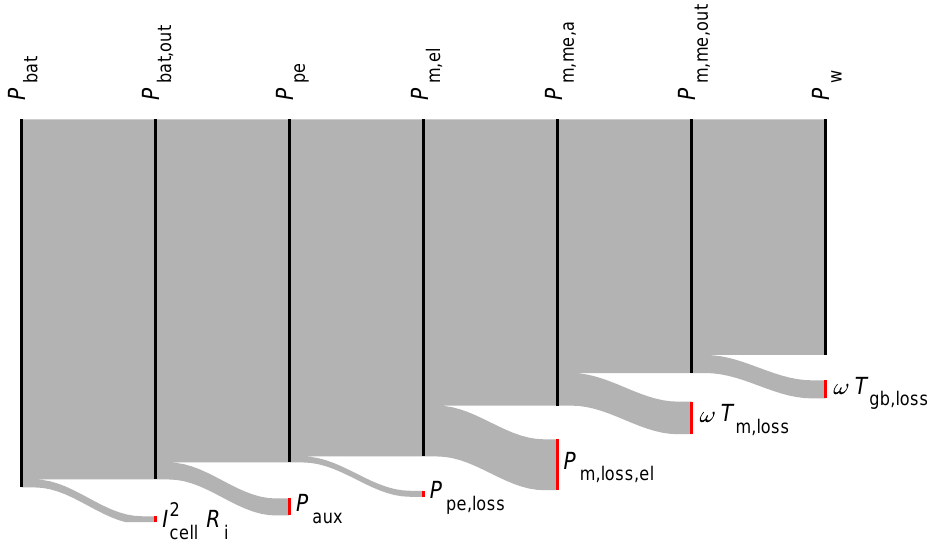
Figure 1. Power flow in the electric powertrain and the losses considered in the optimization in red. Battery losses are modeled as an equivalent electric circuit model. Based on the Rint model, battery output power P bat,out is defined as